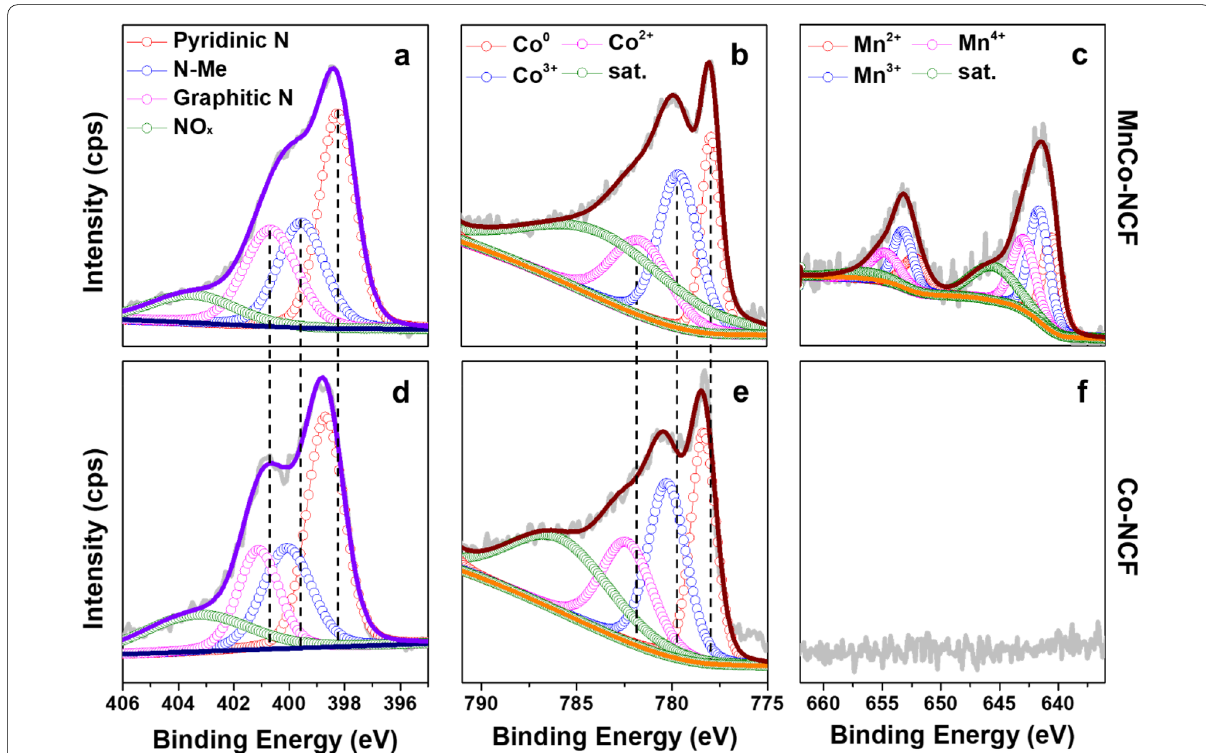
Fig. 3 Chemical structure of MnCo‑NCF. a N1s, b Co2p, and c Mn2p XPS spectra of MnCo‑NCF. d N1s, e Co2p, and f Mn2p XPS spectra of Co‑NCF after